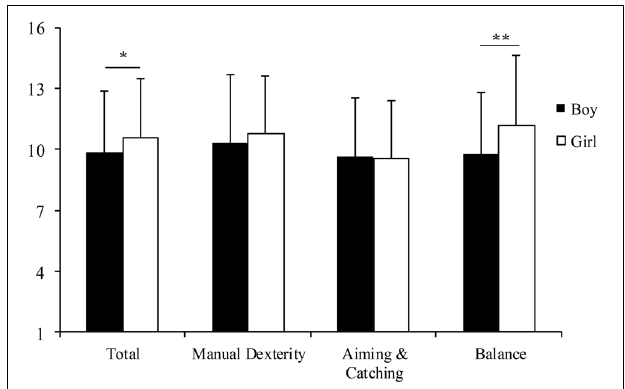
FIGURE 1 | Total and component scores for boys and girls. Bars and error bars, respectively, represent means and SDs. ∗∗ p < 0.01; ∗ p < 0.05.